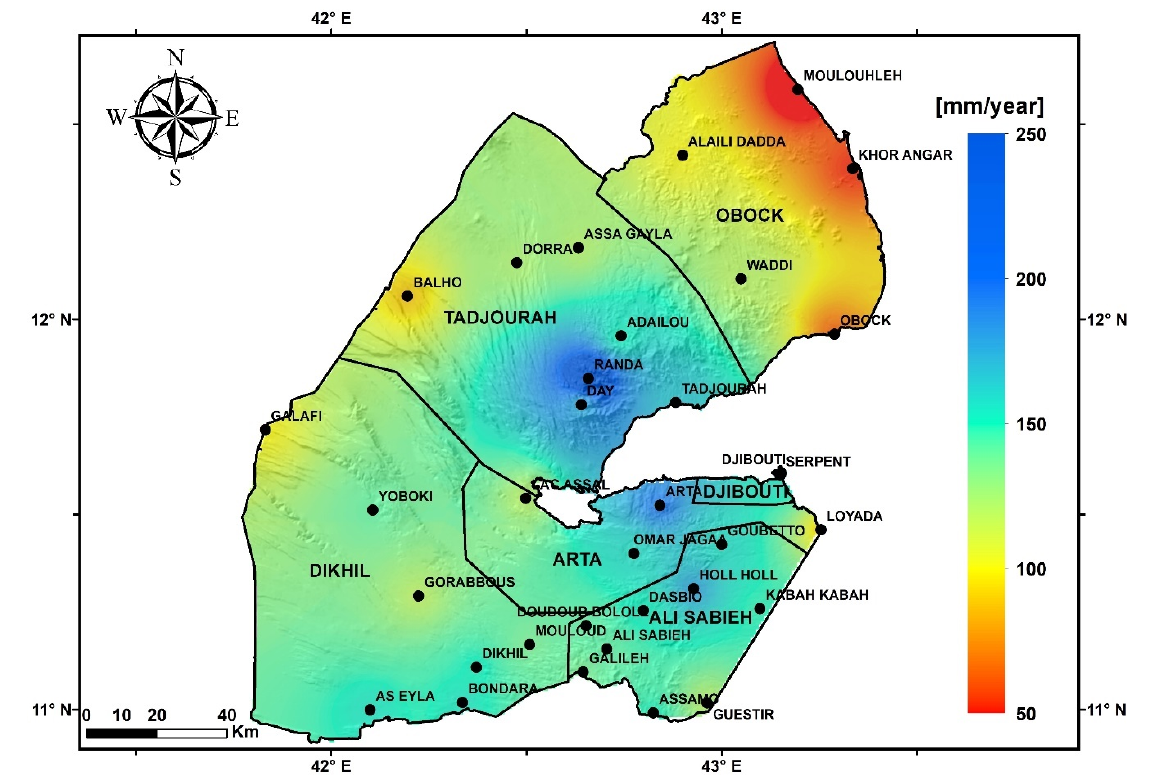
Figure 3. Spatial distribution of mean annual rainfall over the Republic of Djibouti based on 35 meteorological stations.